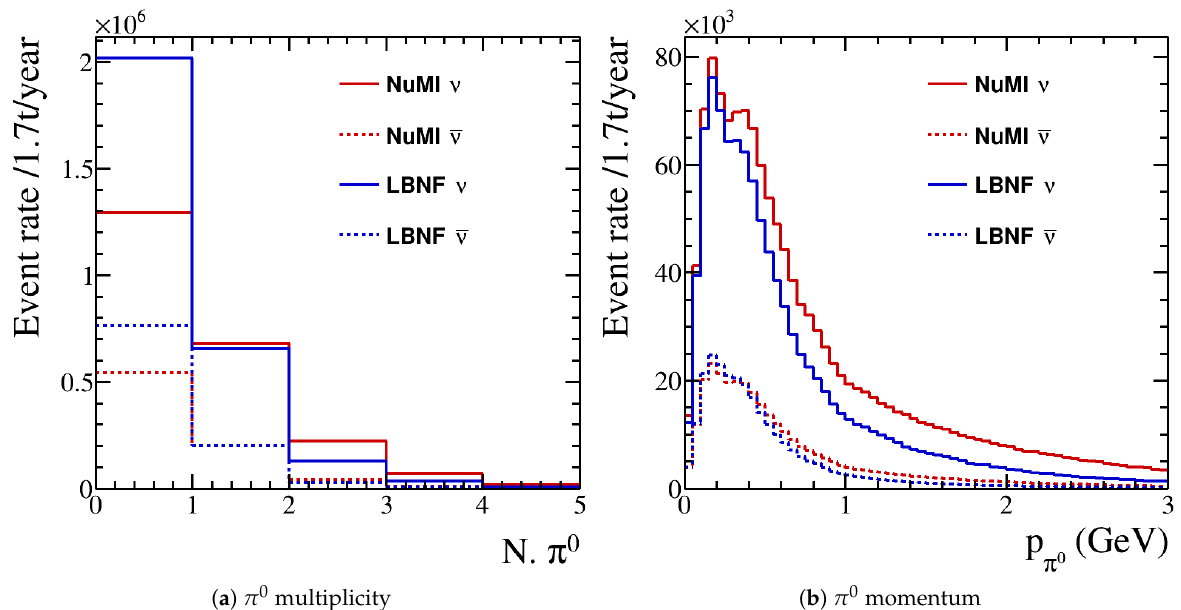
Figure 30. The expected yearly rates of π 0 ’s produced at the vertex, as a function of event multiplicity and their momentum, expected in the demonstrator’s 1.7t LAr mass for the NuMI ME and LBNF fluxes, produced using GENIE v2.12.10 [71]. Note that every π 0 from each event is included in the momentum distribution, regardless of containment.